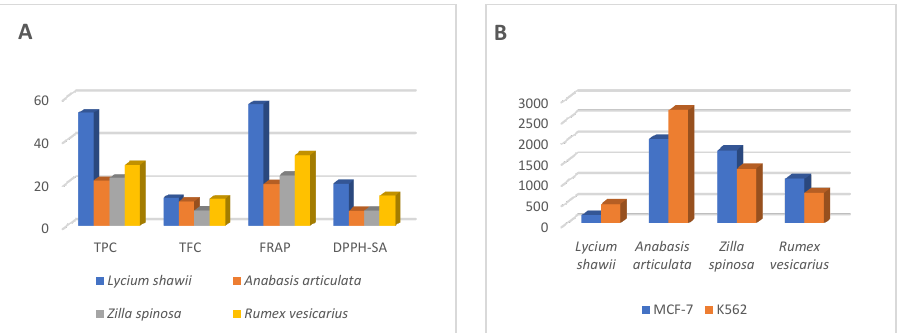
Figure 7. Comparative flavonoids and phenolics contents, antioxidant ( A ), and anticancers ( B ) activities.